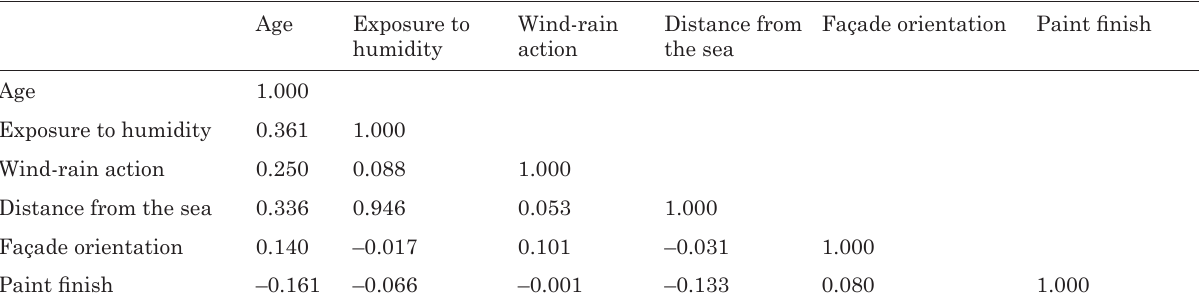
Table 9. Matrix of bivariate correlations between the degradation factors analysed